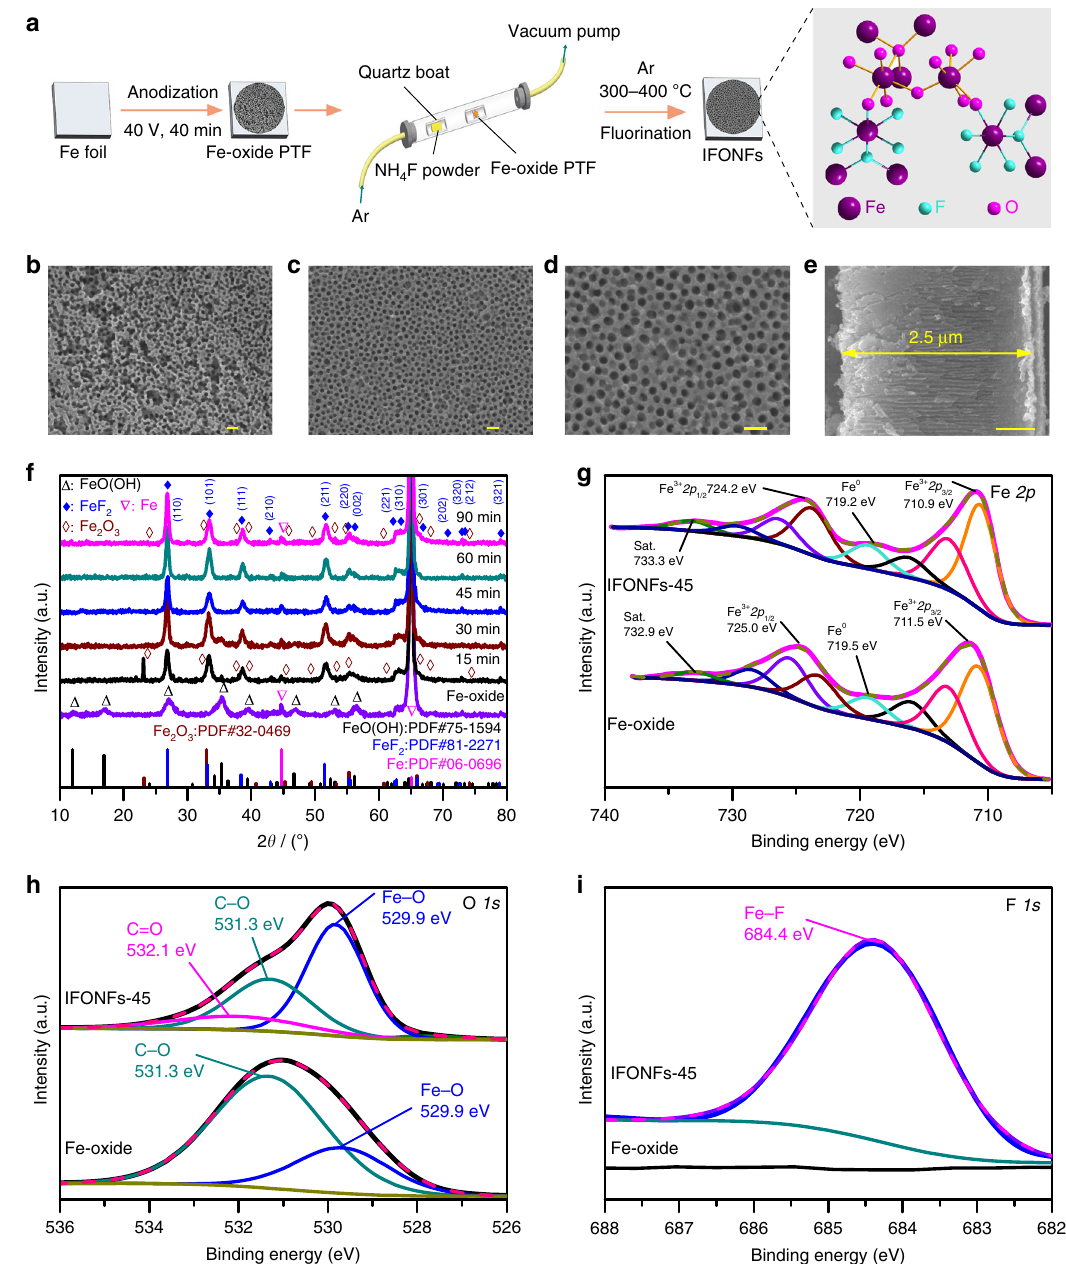
Fig. 1 IFONFs fabricated from commercial Fe foil with anodization/ fl uorination process. a Schematic of the fabrication process for IFONFs, starting with a Fe foil. SEM top-view images of b Fe-oxide PTF and c IFONFs-45. Scale bar, 100 nm. d High-magni fi cation SEM image of IFONFs-45. Scale bar, 100 nm. e SEM cross-sectional image of IFONFs-45. Scale bar, 500 nm. f XRD spectrum of Fe-oxide PTF and IFONFs synthesized with various T fl uorinated . For Fe-oxide PTF, the diffraction peaks at 2 θ = 11.9°, 16.9°, 26.9°, 35.3°, 39.4°, 46.6°, 53.1°, and 56.2° suggests the formation of FeO(OH) (PDF#75 – 1594) with anodization. The Fe-oxide PTF anodically grown on Fe substrates consists of FeO(OH) and Fe, while the Fe peaks are from Fe foil. With short T fl uorinated of 15 min, the diffraction peaks of both Fe 2 O 3 and FeF 2 are sharp and intense, and Fe 2 O 3 is obtained by annealing FeO(OH) in an argon atmosphere during fl uorination 47 . With T fl uorinated of 45 min, the primary diffraction peaks associated with Fe 2 O 3 are declined while both peaks for FeF 2 (110) and (101) are distinguished, indicating a T fl uorinated -dependent phase transformation for iron fl uoride-oxide in fl uorination condition. Fe 2 O 3 and FeF 2 could coexist with fl uorination, and FeF – 2271). High-resolution XPS in g Fe 2 p , h O 1 s , and i F 2 p 2 phase has a tetragonal structure with a P42/mnm space group (PDF#81 regions for Fe-oxide PTF and IFONFs-45, respectively. For IFONFs-45 in g , two core-level signals of Fe 2 p located at ∼ 710.9 and 724.2 eV are attributed to Fe 2 p 3/2 and Fe 2 p 1/2 , which are negatively shift ~0.6 and ~0.8 eV relative to those in the raw Fe oxide, respectively, owing to the bond formation of Fe and F elements. The satellite peaks at ∼ 719.9 and 733.3 eV are attributed to Fe 0 , suggesting the presence of elemental Fe on the surface. Moreover, the O 1 s peak of IFONFs-45 in h is shifted to lower binding energy with respect to the Fe-oxide PTF, which attributes to the formation of FeF 2